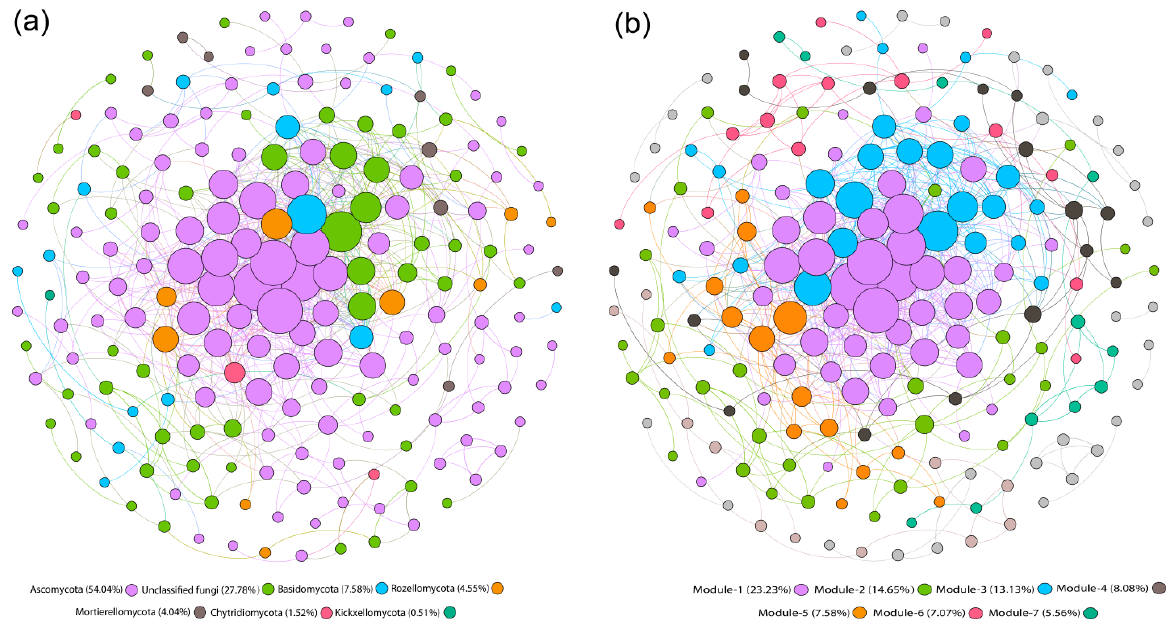
Figure 6. Co-occurrence network of fungal communities in red soil. The co-occurrence network based on correlation analysis for fungal communities: ( a ) the network’s nodes are colored according to their phylum; ( b ) the nodes in the network are colored according to modularity class. The size of each node is proportional to the relative abundance of specific taxa. The connections showing the strong (spearman’s ρ ≥ 0.6) and significant ( p ≤ 0.05) correlations.